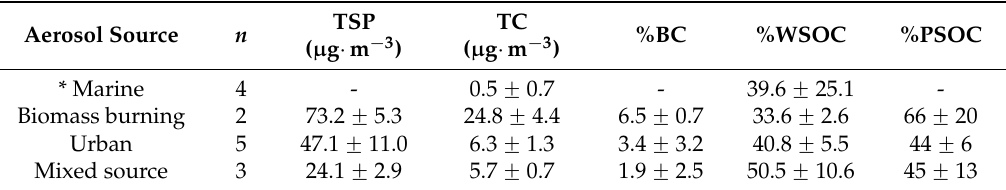
Table 1. Average total suspended particulates (TSP) and total carbon (TC) concentrations and carbon percentages (relative to TC) for each aerosol source